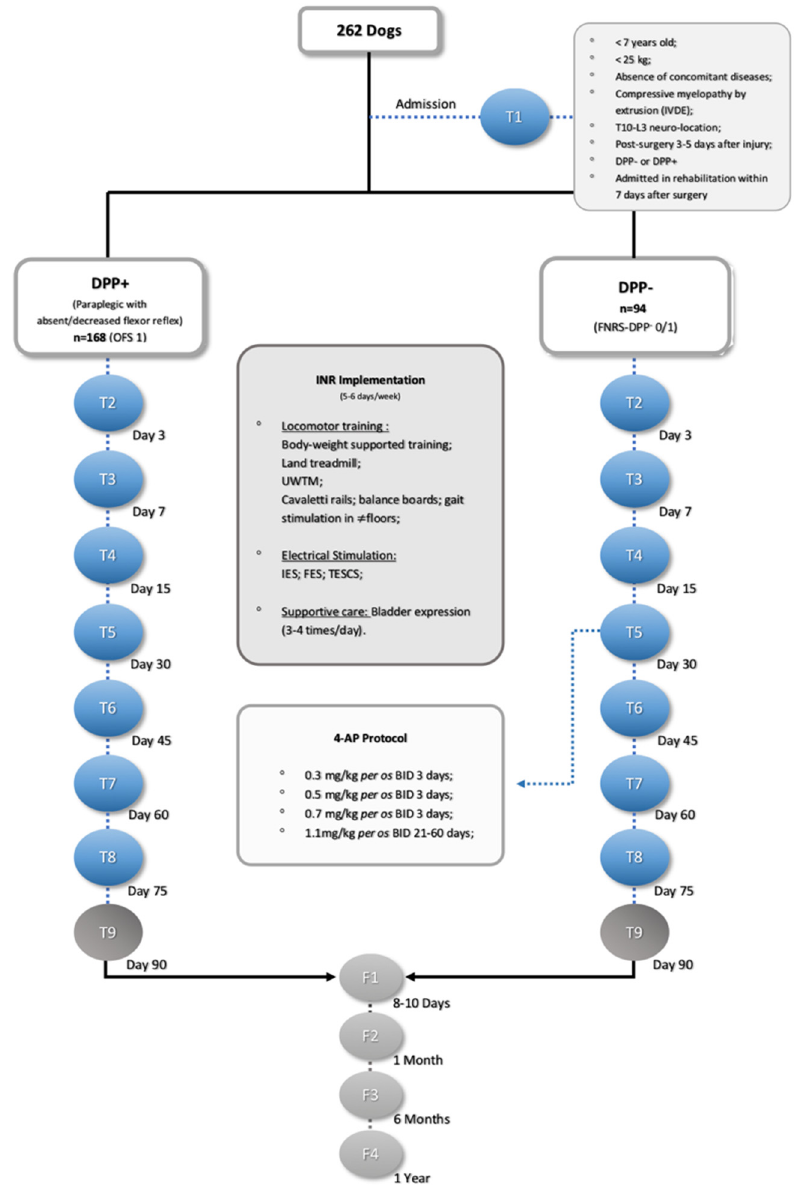
Figure 2. Flow diagram (as recommended by Strengthening the Reporting of Observational Studies in Epidemiology, STROBE, guidelines) illustrating the study design. IVDE: intervertebral disc extrusion; DPP: deep pain perception, INR: intensive neurorehabilitation, OFS: open field score, FNRS-DPP − : functional neurorehabilitation scale for thoracolumbar SCI dogs without DPP, UWTM: underwater treadmill, IES: interferential electrical stimulation, FES: functional electrical stimulation, TESCS: transcutaneous electrical spinal cord stimulation, and 4-AP: